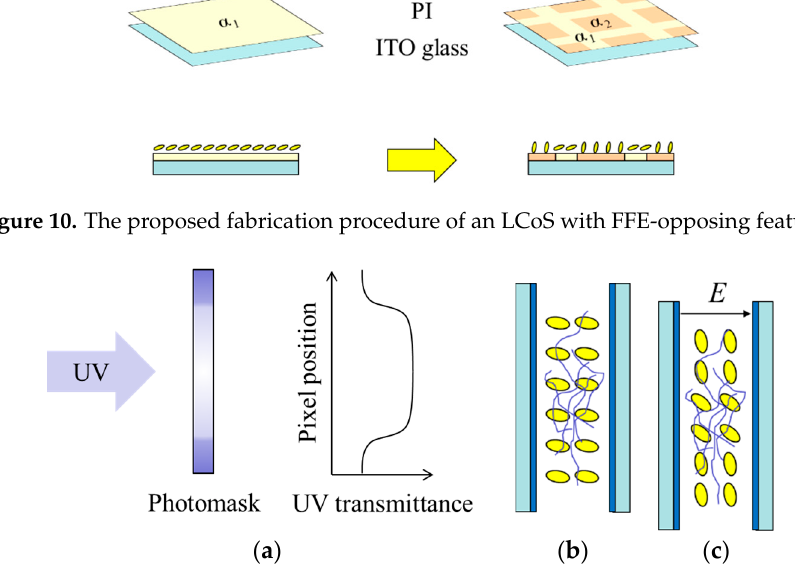
Figure 10. The proposed fabrication procedure of an LCoS with FFE-opposing features.